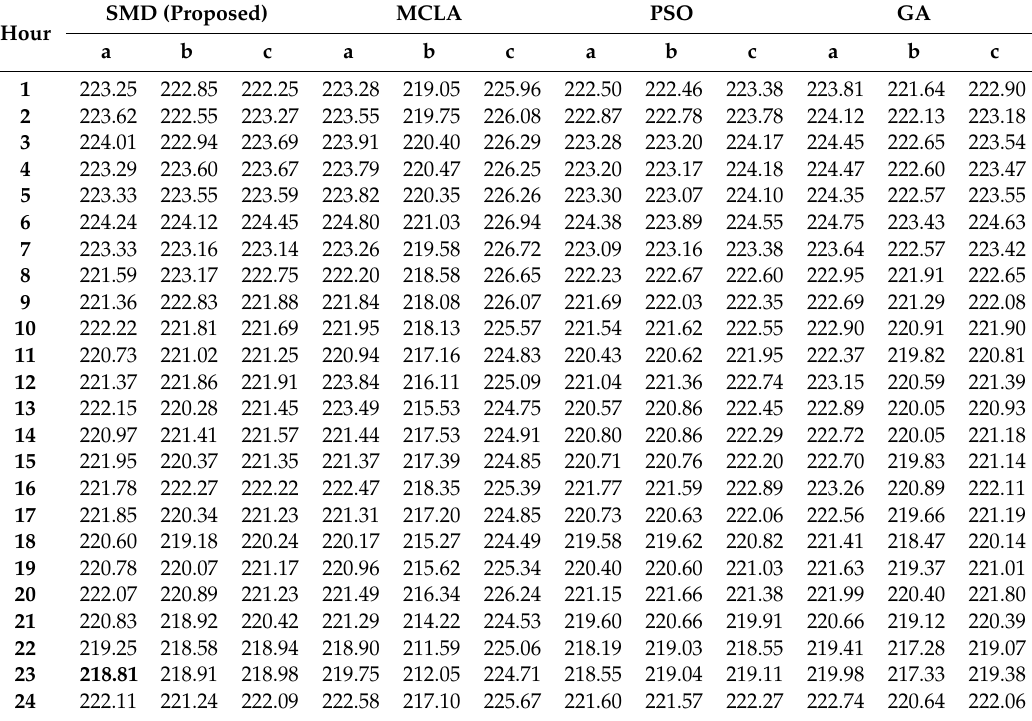
Table A5. Comparison between the hourly phase voltages calculated with di ff erent algorithms, at the level of the farthest pillar P95,